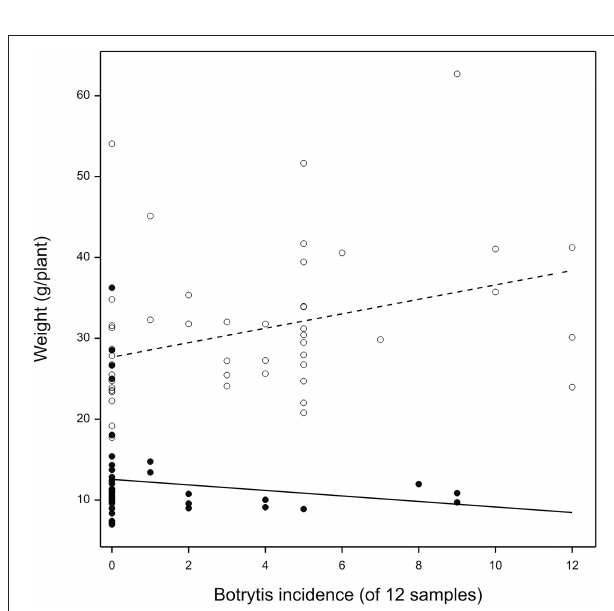
FIGURE 6 | Dry weight at harvest (g) of lettuce plants grown in shaded (closed circles) or unshaded (open circles) glasshouse conditions in relation to the number of tissue samples (of 12) from each plant in the experiment ( n = 96 ) from which Botrytis isolates could be recovered after surface